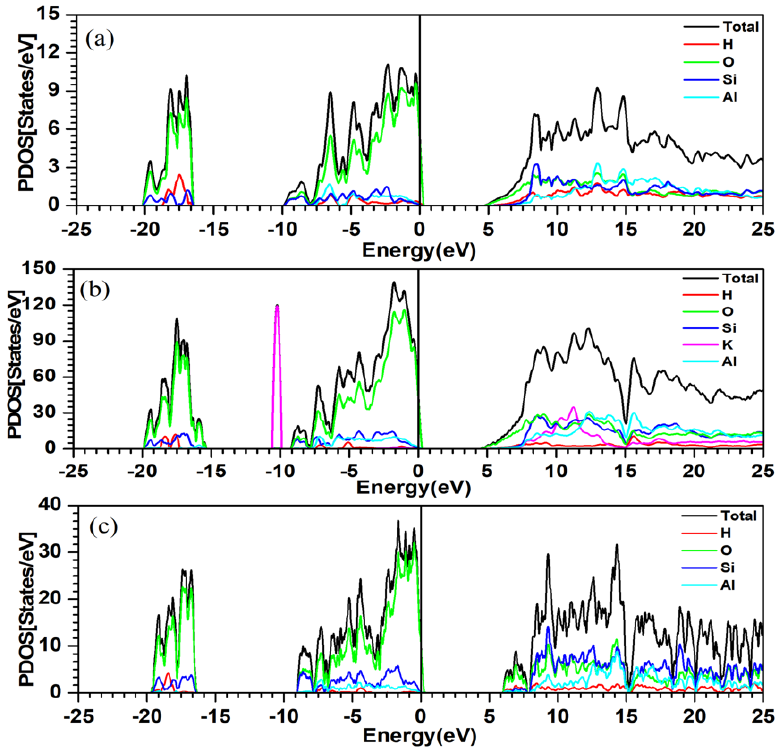
Figure 3. TDOS and PDOS of three clay mineral crystals for ( a ) kaolinite, ( b ) muscovite, and ( c ) montmorillonite.